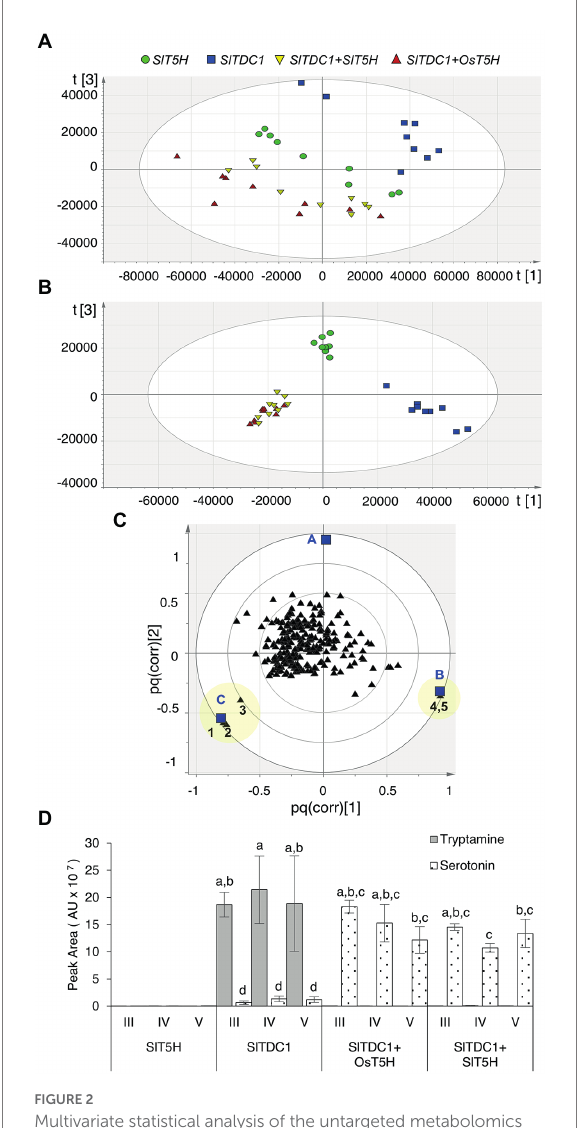
FIGURE 2 Multivariate statistical analysis of the untargeted metabolomics dataset (positive ionization) following the HPLC-ESI-MS analysis of Nicotiana benthamiana plants transiently expressing SlTDC1 and T5H genes. (A) PCA score scatter plot. (B) O2PLS-DA score scatter plot. (C) O2PLS-DA correlation loading plot, with each metabolite represented by a black triangle and classes by blue squares (A = SlT5H , B = SlTDC1 , and C = SlTDC1 + OsT5H and SlTDC1 + SlT5H ). The yellow area highlights metabolites characteristic of each class: 1 and 2 represent molecular and fragment ions of serotonin (177 and 160 m/z , respectively), 3 is an unidentified metabolite (222 m/z ), and 4 and 5 are molecular and fragment ions of tryptamine (161 and 144 m/z , respectively). (D) Levels of tryptamine and serotonin. AU = arbitrary unit. Data are means ± standard deviations ( n = 3). Different letters on bars indicate that means are significantly different according to post- hoc Tukey-ANOVA (p <